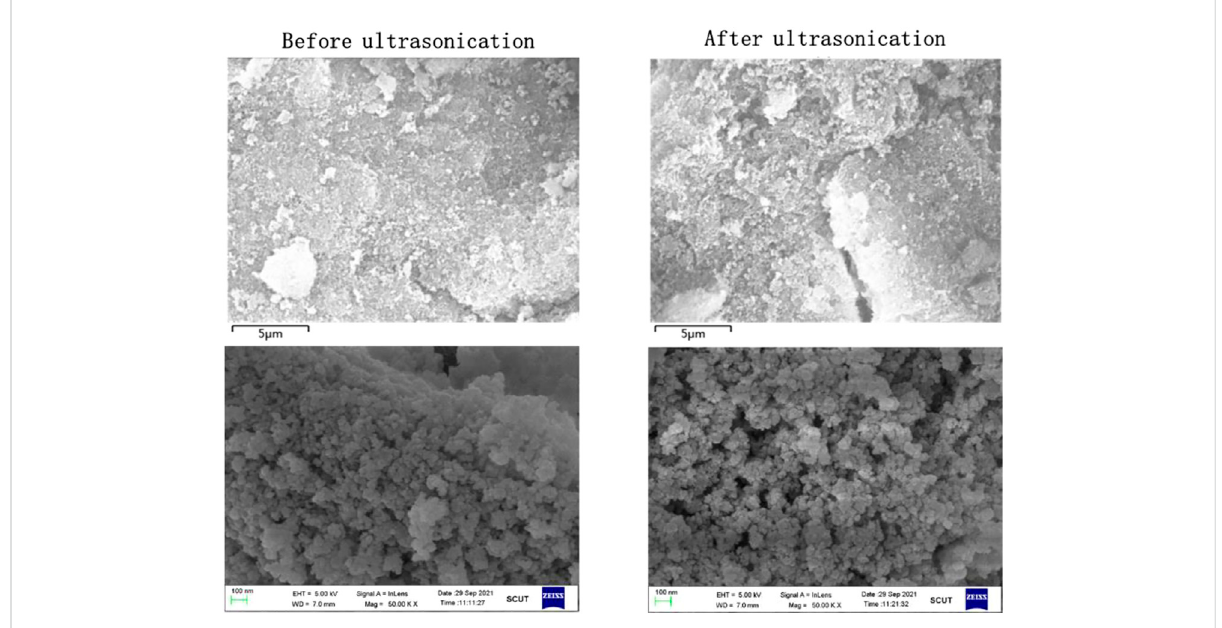
FIGURE 5 Topography change of chromium sludge (EPS1) before and after ultrasonic treatment.